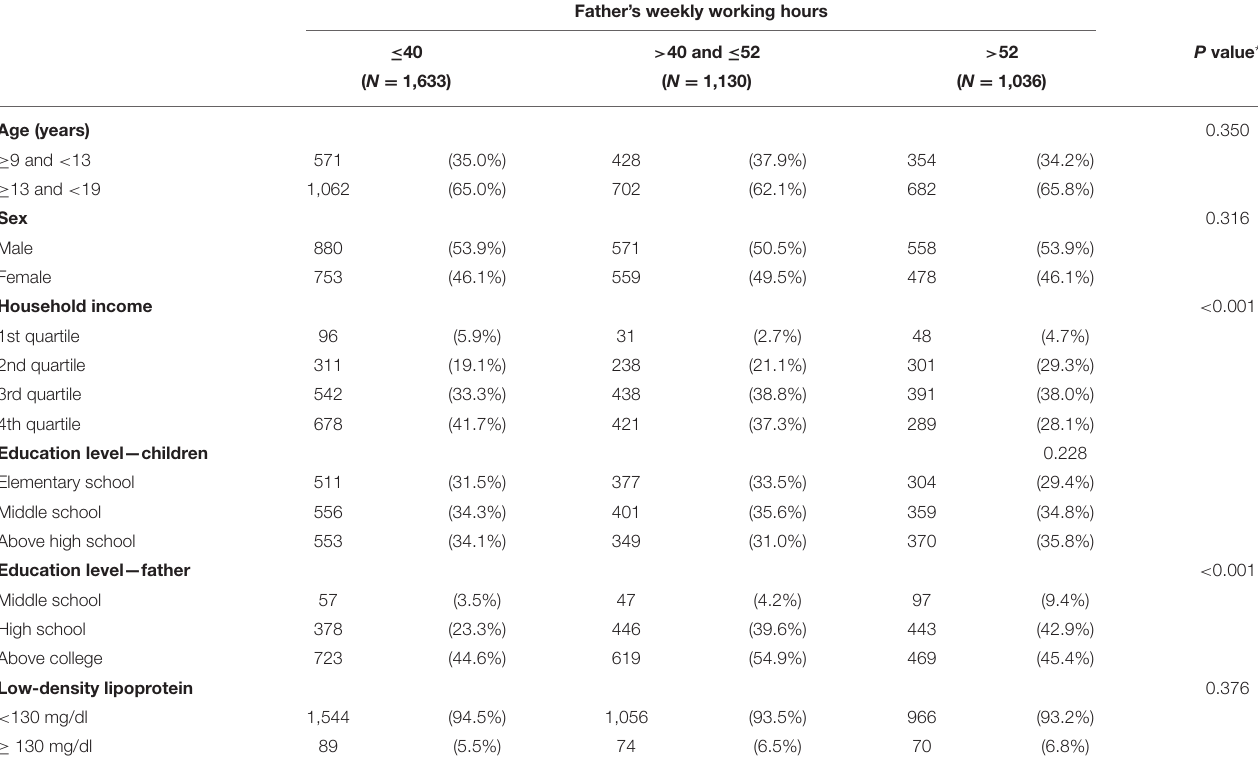
TABLE 2 | Baseline characteristics of study participants divided by working hours of the